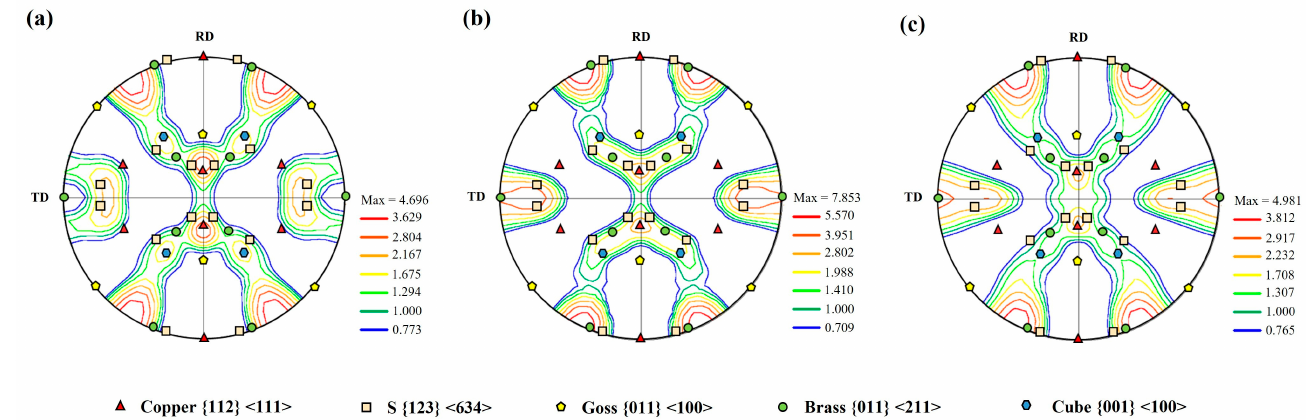
Figure 7. {111} pole figures for the ( a ) M1, ( b ) M2 and ( c ) M3 samples after three MARB cycles.